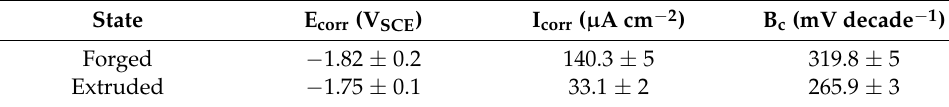
Table 3. The fitting result of the cathode polarization